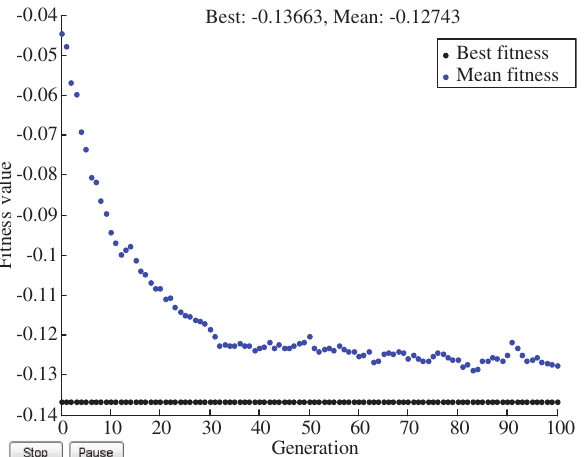
Figure 3. Genetic Algorithm Iterative Process Diagram (Not Including the Decision Variables Zr